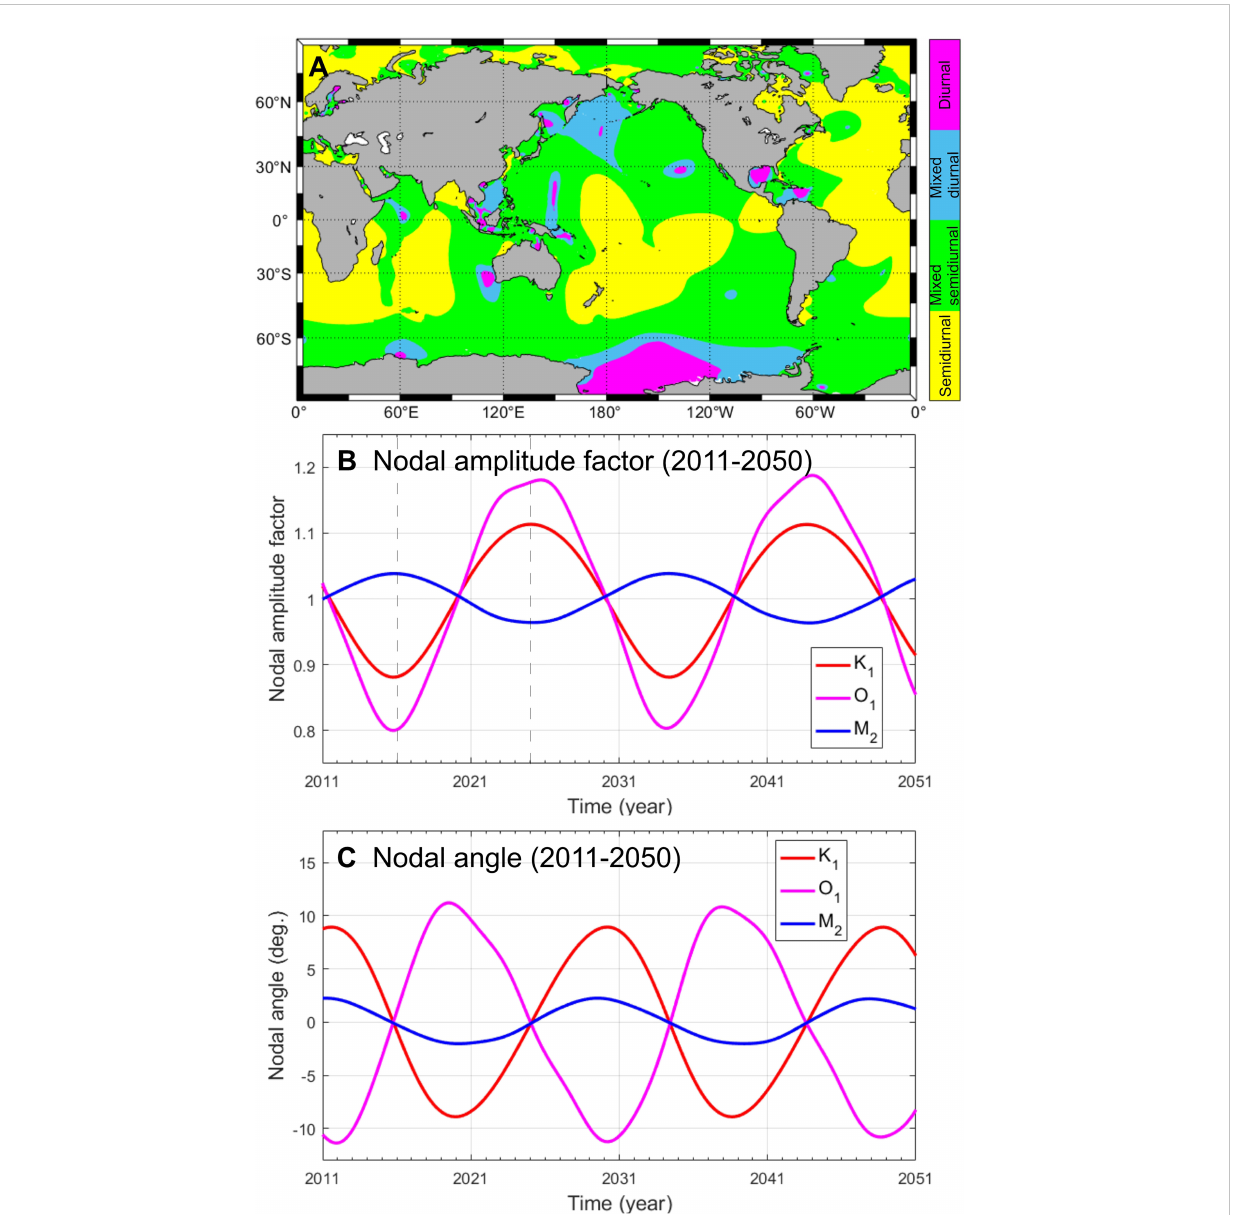
FIGURE 4 Map of (A) global distribution of semidiurnal ( F <0.25), mixed mainly semidiurnal (0.25< F <1.5), mixed mainly diurnal (1.5< F <3.0) and diurnal tides ( F >3.0) (classi fi ed using the tidal form factor amplitude ratio of F =(K 1 +O 1 )/(M 2 +S 2 )), using the FES2014 model database of tidal harmonic constants. Variation in nodal amplitude factors (B) and nodal angles (C) of the three main lunar tidal constituents (K 1 , O 1 and M 2 ) from 2011 to 2050 at Yeosu, on the central south coast of Korea (see location in Figure 1), estimated at daily intervals using T_Tide ’ s t_vuf.m program (Pawlowicz et al.,